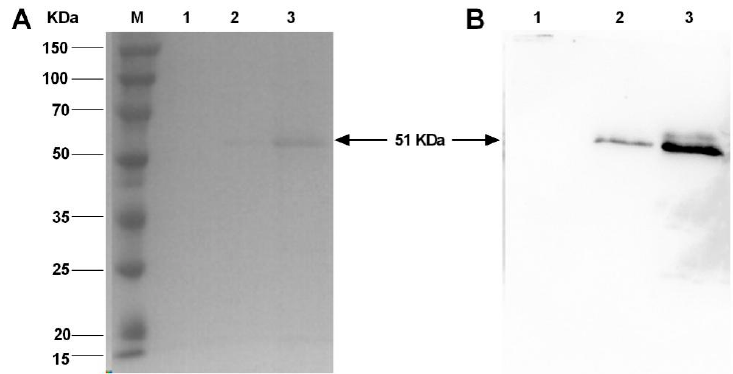
Figure 2. Analysis of recombinant BsDb expression in Pichia pastoris . ( A ) SDS-PAGE analysis: culture supernatant from a negative clone induced by 1% methanol for 96 h (lane 1); culture supernatant